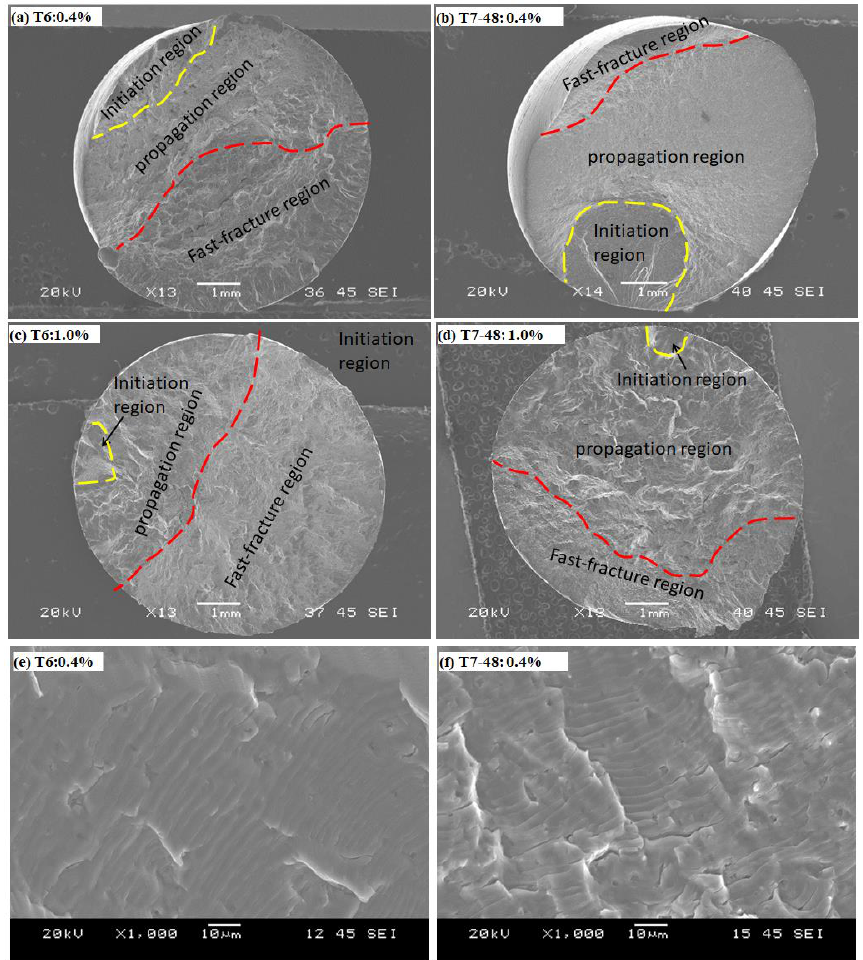
Figure 10. Fatigue fracture surfaces at strain amplitudes of 0.4% and 1.0% under ( a , c , e ) T6 and ( b , d , f ) T7-48 conditions.